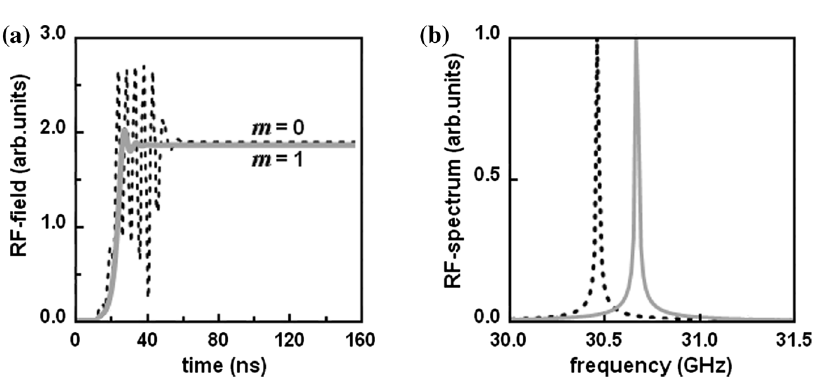
FIG. 2. Simulations of the “ freely-oscillating ” Ka-band coaxial BWO (without the 2D Bragg synchronizer) of moderate transverse 50 A. (a) Establishment of the stationary oscillation regime at different azimuthal harmonics = λ ∼ 4 and beam current I size l x beam ¼ (which depends on the initial conditions): azimuthally symmetrical mode m ¼ 0 (black dotted line) and nonsymmetrical mode m ¼ 1 (gray solid line). (b) The corresponding radiation